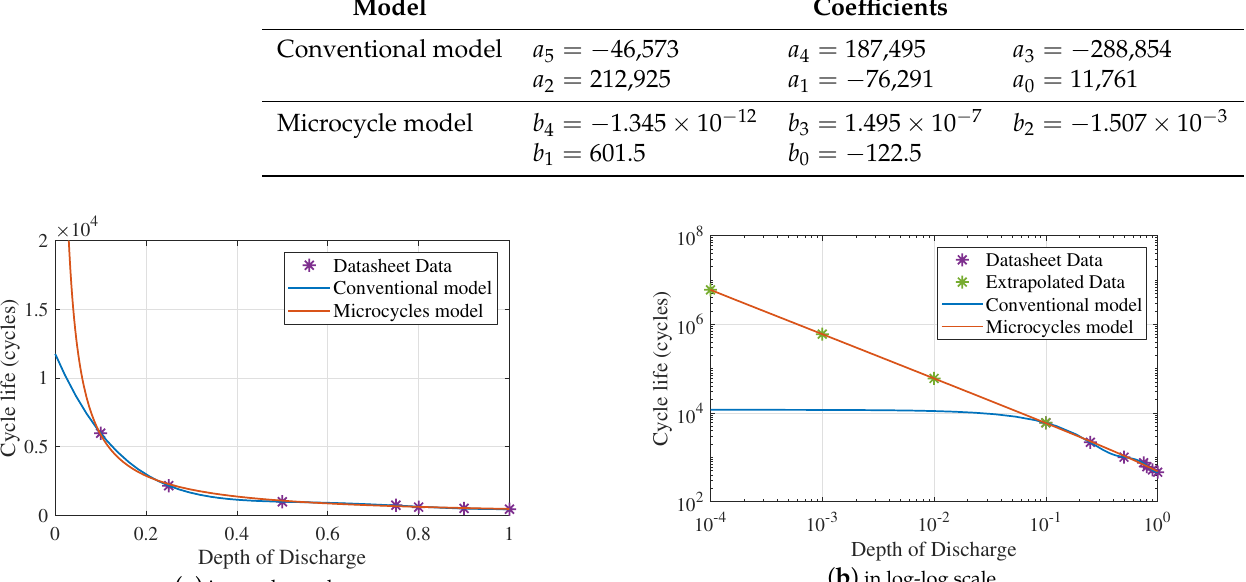
Figure 8. Battery cycle life vs. depth of discharge (DoD)